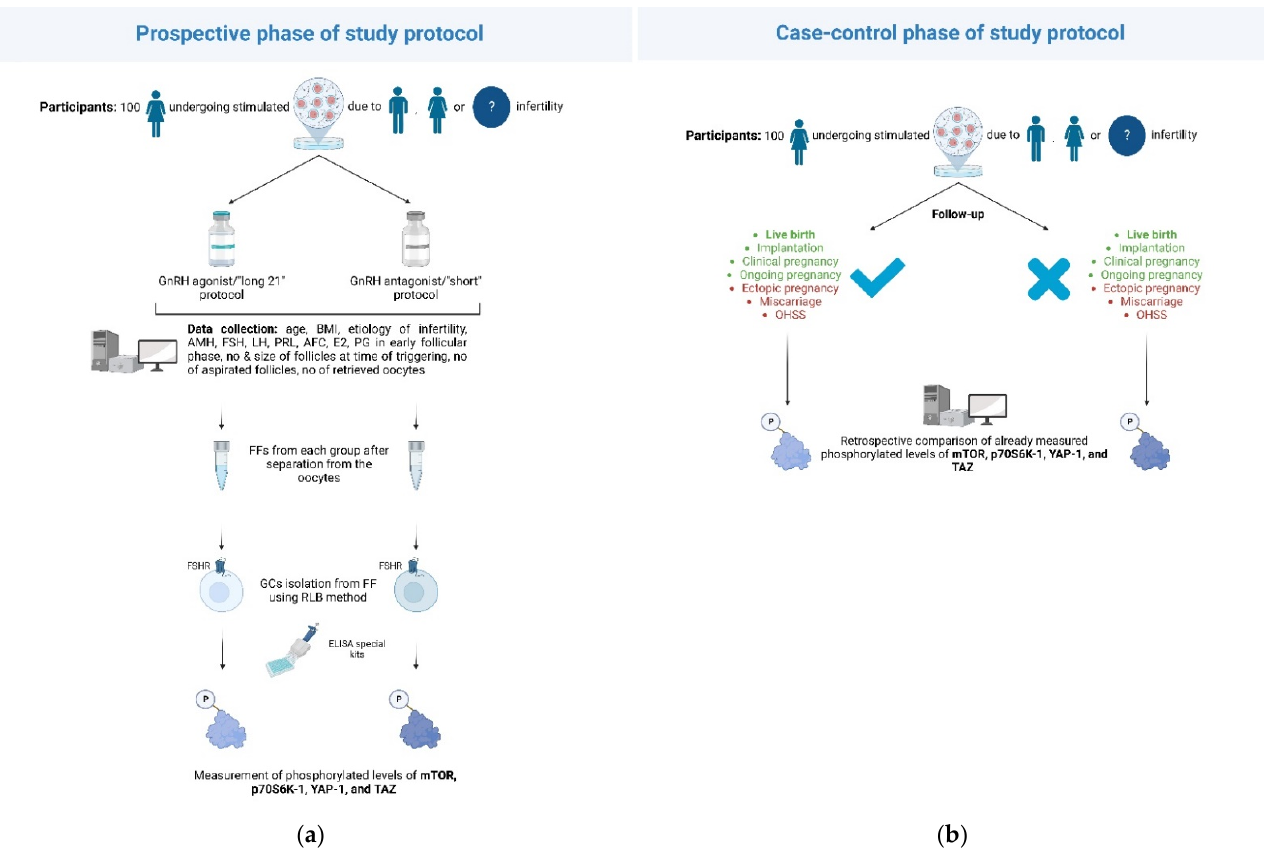
Figure 1. Illustration of the prospective and case-control phases of the planned study. Eligible participants will be women aged 30–40 undergoing stimulated IVF cycle (i.e., not undergoing natural or mild IVF protocols) due to infertility of male, female factor, or unexplained etiology. The number of participants (100) refers to the targeted sample of the pilot phase. Following the successful completion of this phase, more study centers and subjects are intended to be included. ( a ) Prospective phase of the designed study. Levels of certain phosphorylated components of the investigated mTOR and Hippo pathways will be compared between women receiving GnRH agonist/“long 21”protocols and those receiving GnRH antagonist/”short” protocols. These levels will be measured via special ELISA kits by using follicular fluid-isolated ovarian GCs from each group. ( b ) Case-control phase of the planned study. Already measured levels of certain phosphorylated components of the investigated mTOR and Hippo pathways will be retrospectively compared between women achieving predefined (positive/negative) IVF endpoints and those not. Both schemes were created with Biorender.com (www.biorender.com, 19 September 2022). A license for the use of BioRender icons appearing in both schemes and the publication has been granted. Both schemes are original and were created by the authors. Abbreviations: GnRH, gonadotropin-releasing hormone; BMI, body mass index; AMH, anti-Mullerian hormone; FSH, follicle stimulating hormone; LH, luteinizing hormone; PRL, prolactin; AFC, antral follicle count; E2, estradiol; PG, progesterone; no, number; FF, follicular fluid; GC, granulosa cell; RLB, red blood cell lysing buffer; ELISA, enzyme-linked immunosorbent assay; mTOR, the mechanistic target of rapamycin; p70S6K-1, ribosomal protein S6 kinase beta-1; YAP-1, yes-associated protein-1; TAZ, transcriptional coactivator with PDZ-binding motif; OHSS, ovarian hyperstimulation syndrome.